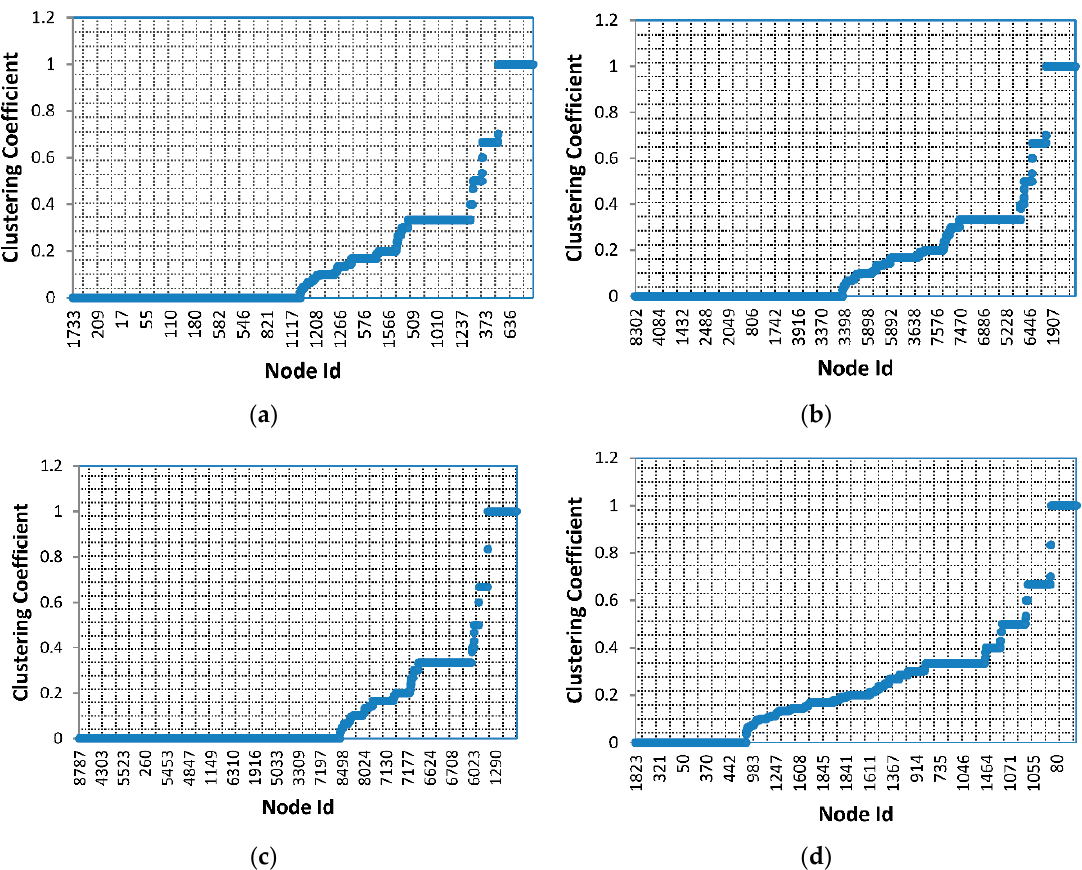
Figure 6. Clustering coefficient distribution of sandstone three-dimensional pore network: ( a ) 14.1%; ( b ) 16.9%; ( c ) 17.1%; ( d ) 24.6%.